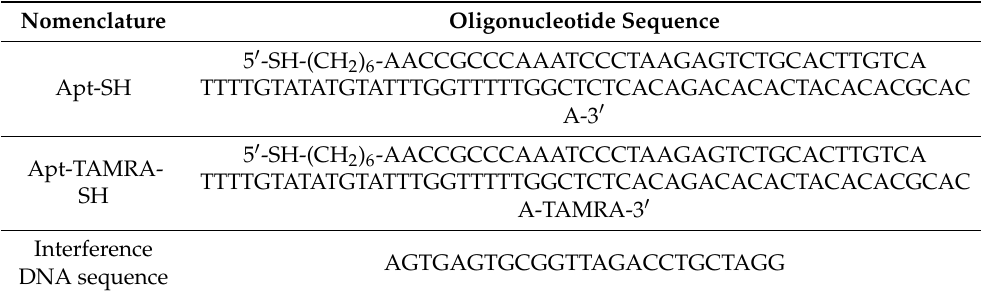
Table 1. DNA sequences used in the present